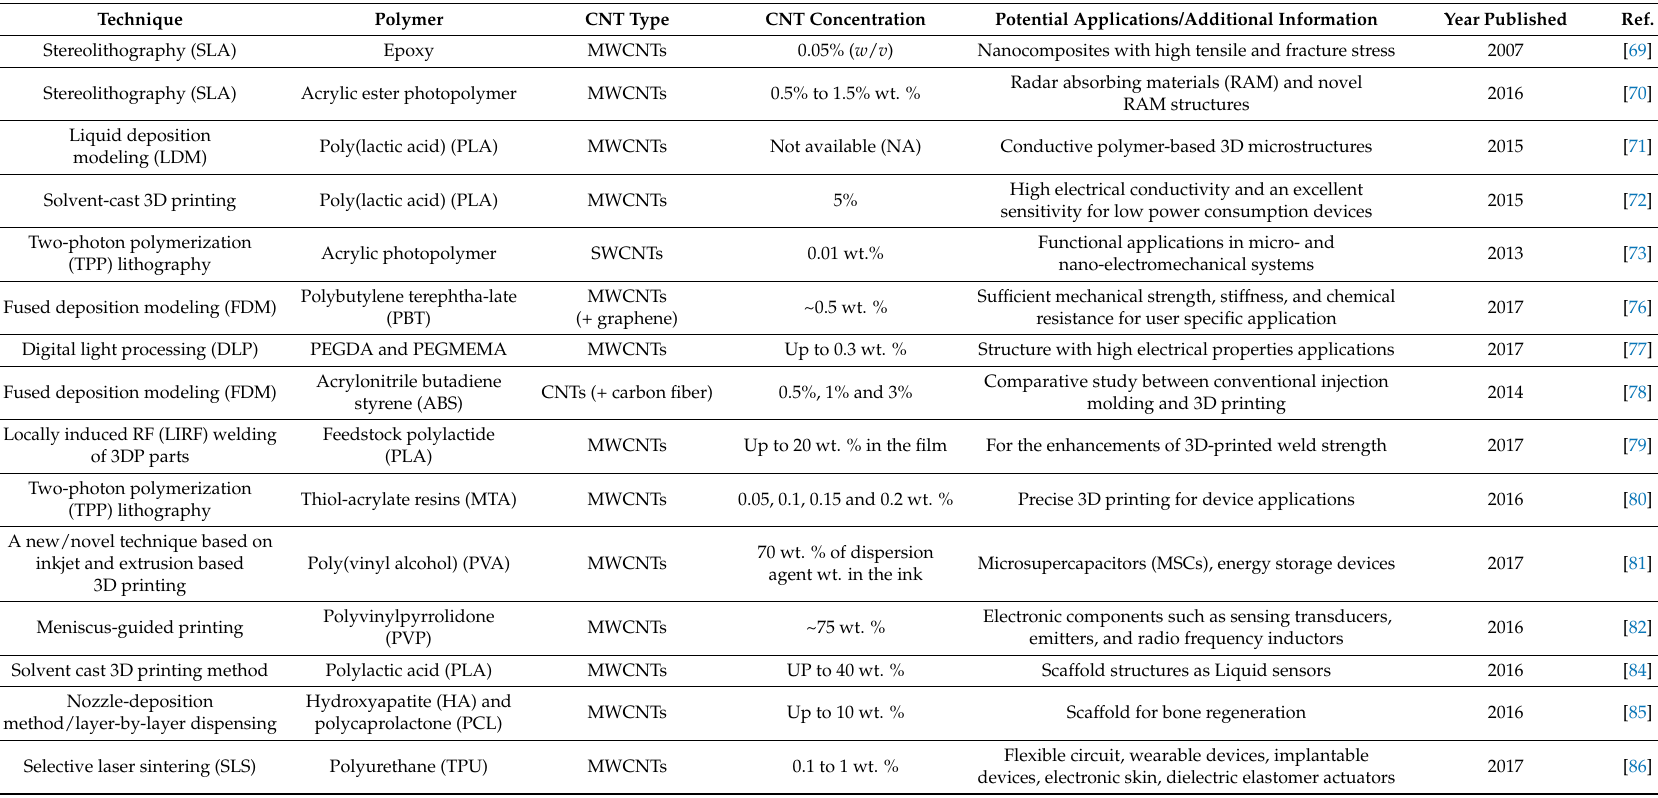
Table 2. CNTs/polymer composites preparation using various additive manufacturing fabrication